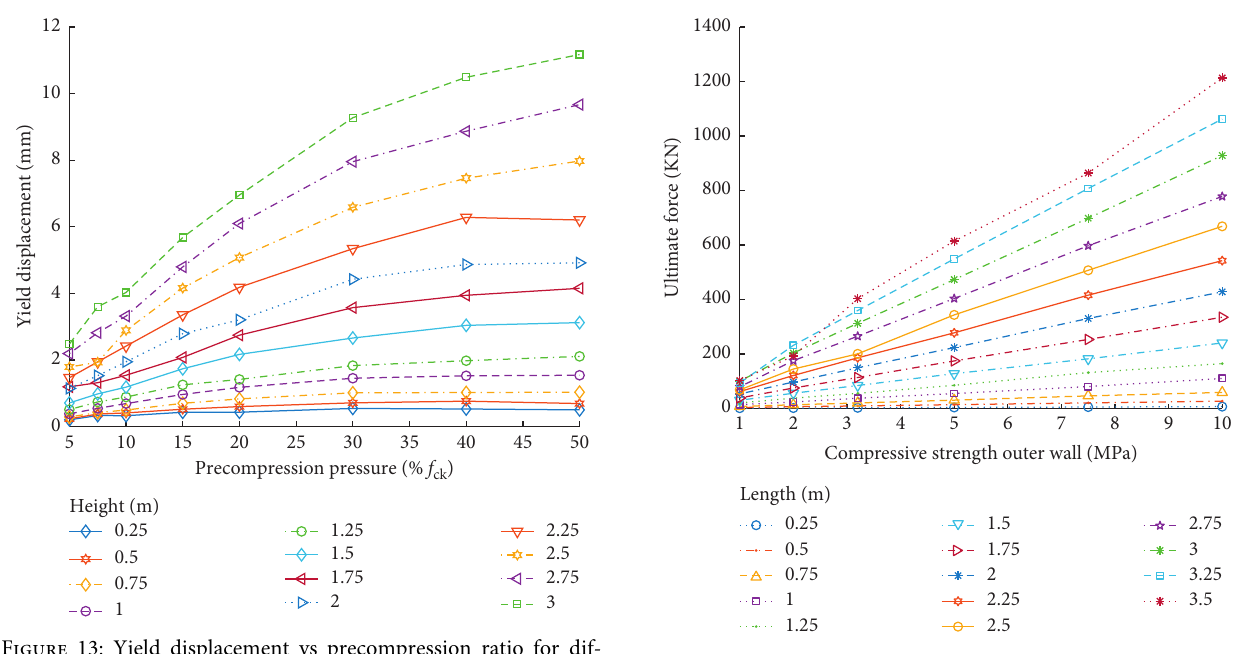
Figure 15: Ultimate force vs compressive strength of outer wall for different lengths.